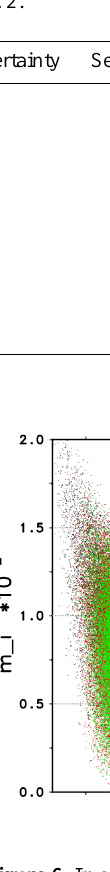
Figure 5. Real part of the refractive index, m r , as a function of the effective radius, r eff , of the solution ensembles for the three lidar setups. The properties of the input ensemble (“truth”) are denoted with a blue cross.